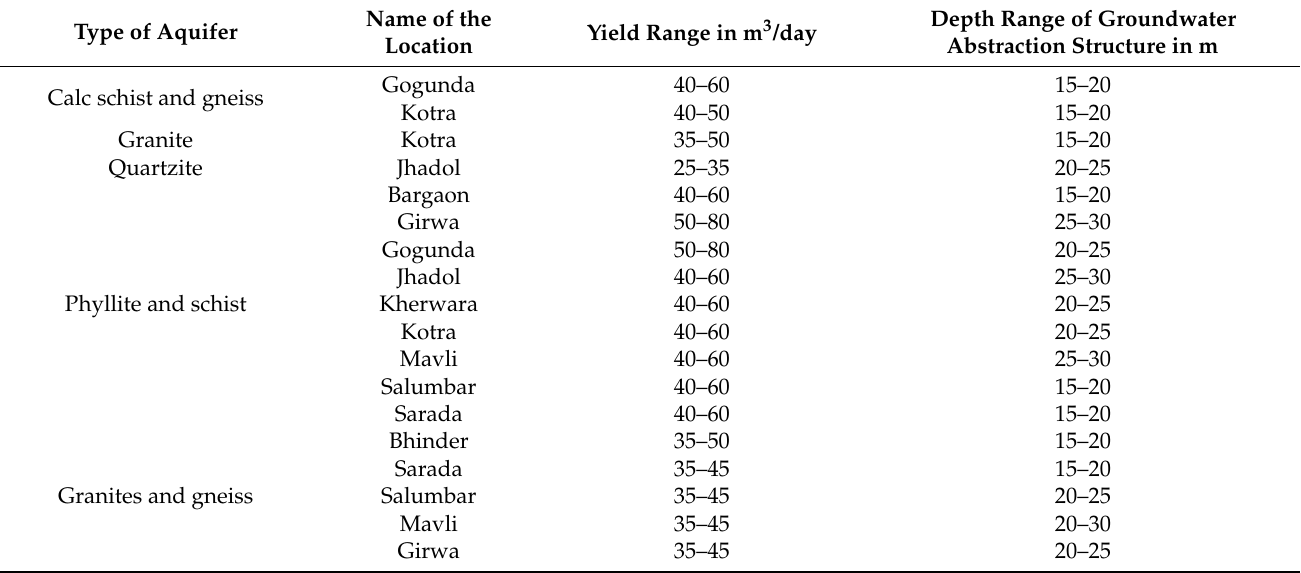
Table 3. The Average Yield of Groundwater at different